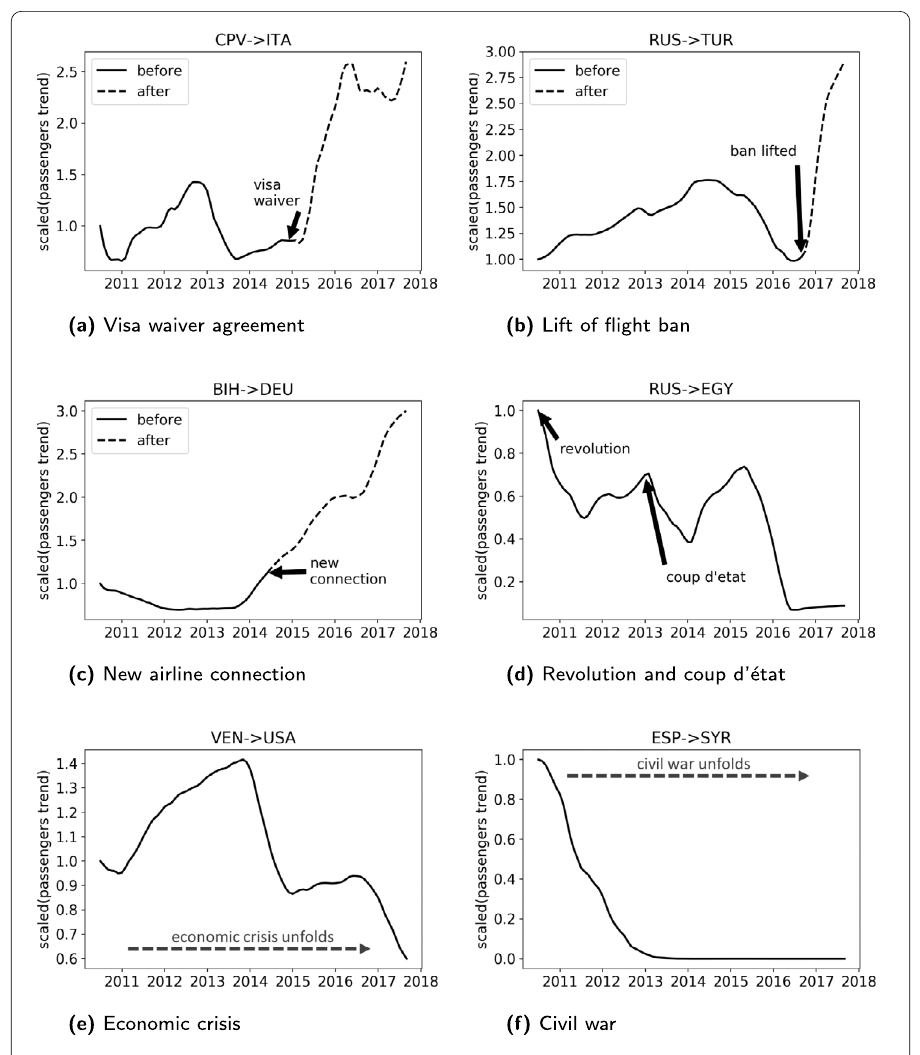
Figure 5 The effect of different events and processes on air passenger mobility: ( a ) visa waiver agreements strengthening mobility rights of Cape Verdeans, ( b ) the lift of a flight ban between Russia and Turkey, ( c ) the introduction of a new budget airline connection between Bosnia and Herzegovina and Germany, ( d ) the revolution and coup d’état in Egypt, ( e ) the economic crisis in Venezuela, and ( f ) the civil war in Syria. In all graphs, the amount of passengers ( y -axis) is normalized, with the initial value set to